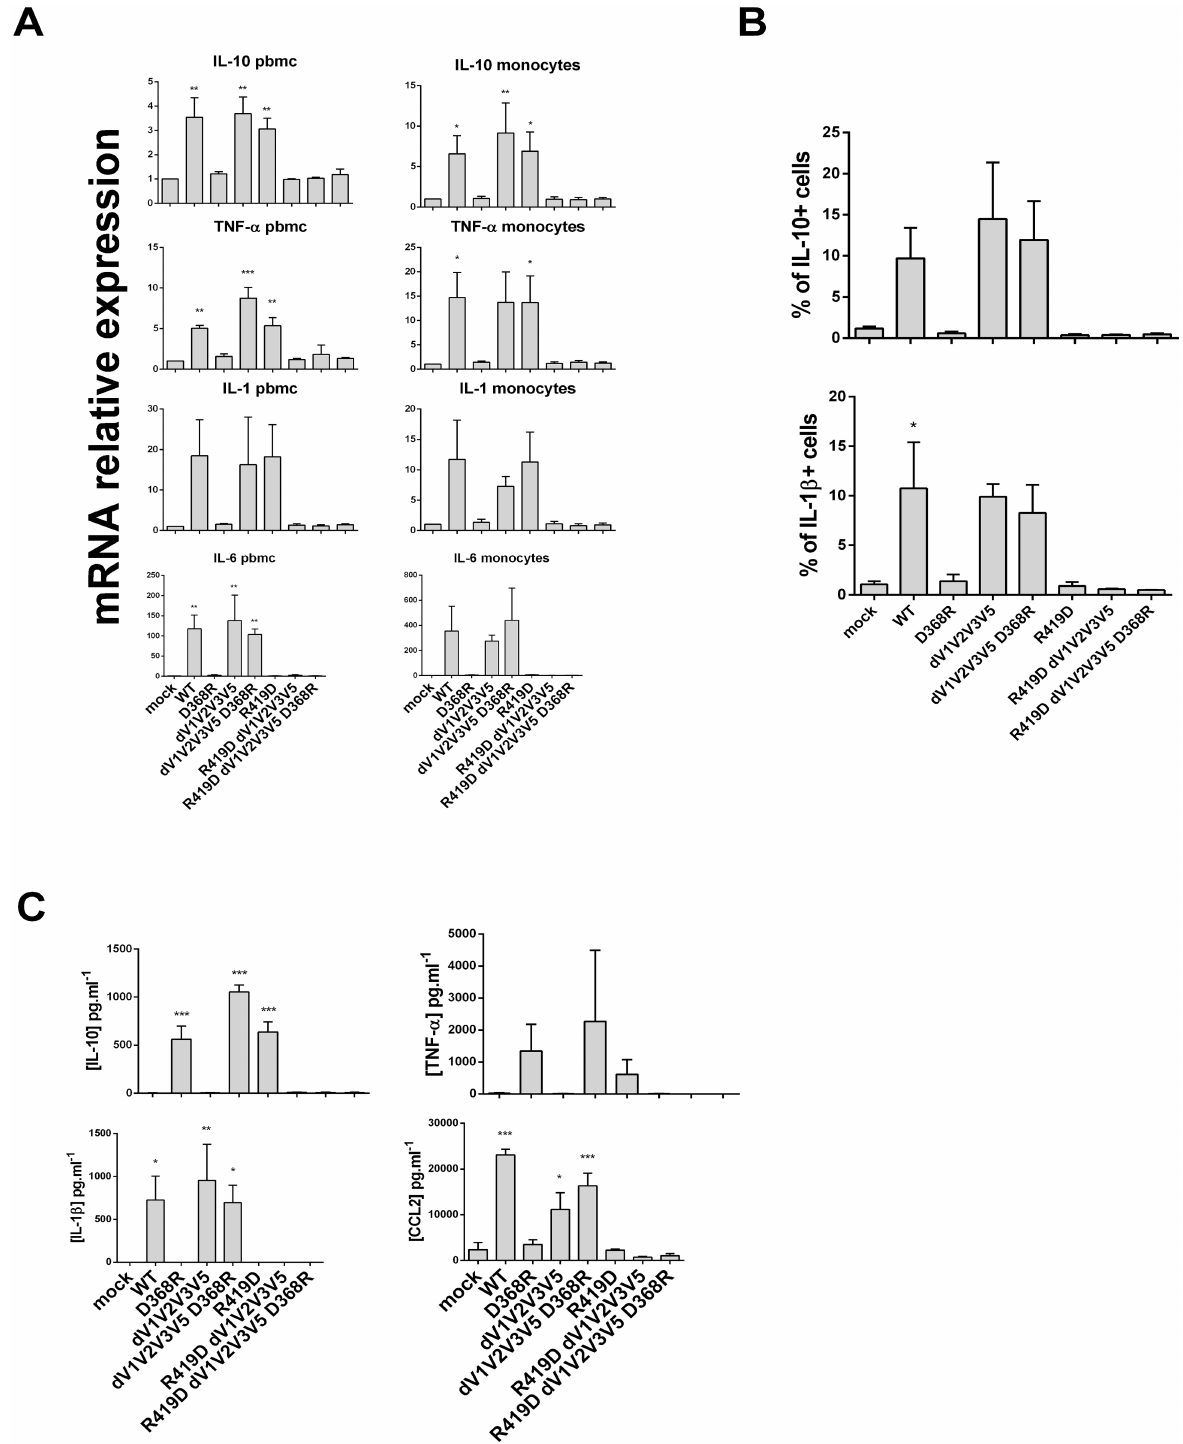
Fig 2. D368Rand R419Dmutations are deleterious for the cytokine burst but dV1V2V3V5 mutation can rescue D368R. Cytokines detectionafter cell stimulationwith the gp120 constructs collection.A) mRNA expressionof cytokines done by RT-qPCR, level of expressionafter stimulationwith gp120 mutants is relativeto the mock control set at 1 for each graph. Left panel: PBMC and right panel: monocytes. B) Flow cytometry analysisof PBMC CD14+ population,expressionof IL-10 and IL1-ß are detected by intra-cellular staining after gp120 mutants’ stimulation.C) PBMC supernatant analysisby ELISA detectionof IL-10, TNF- α , IL-1ß and CCL2 after